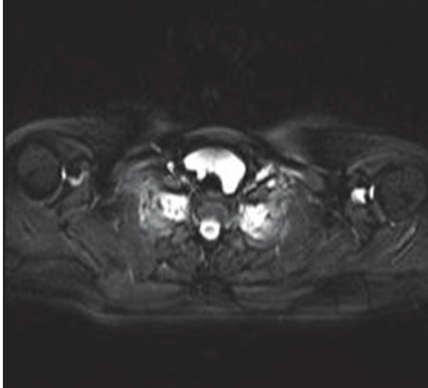
Figure 2: T2-weighted axial MRI showing the lesion’s pretracheal position.